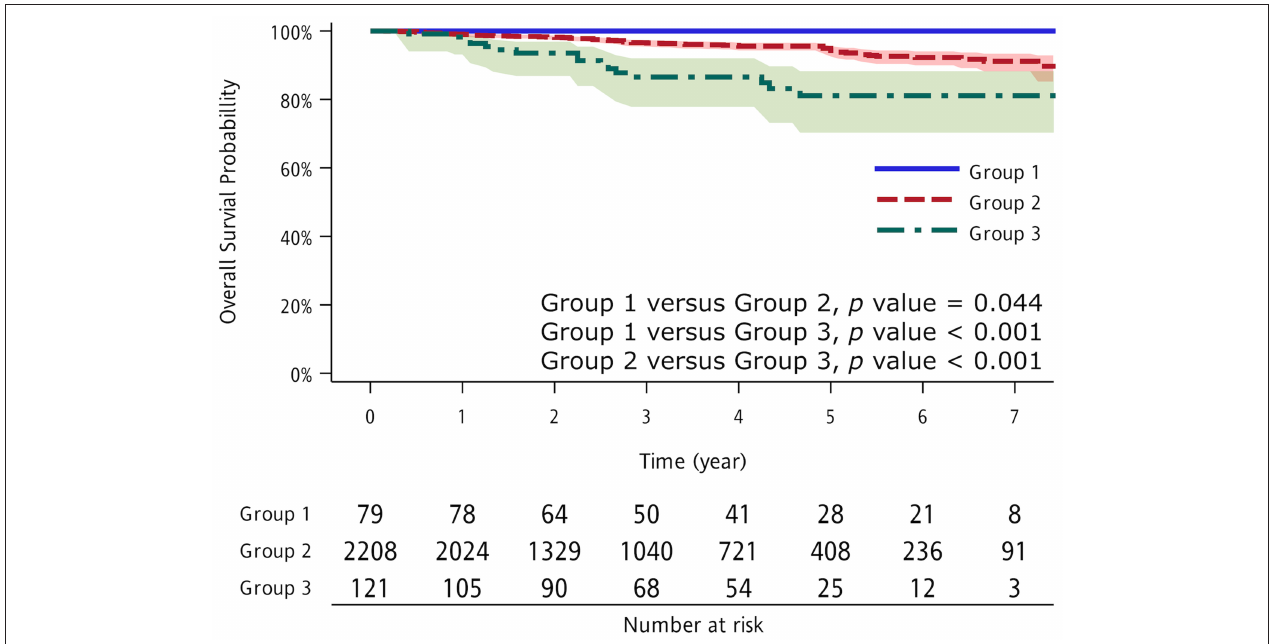
FIGURE 1 | Kaplan–Meier overall survival (OS) curve according to study group. Group 1: thyroid and breast cancer as previous extrapulmonary malignancies; Group 2: no previous extrapulmonary malignancies; and Group 3: other cancers as previous extrapulmonary